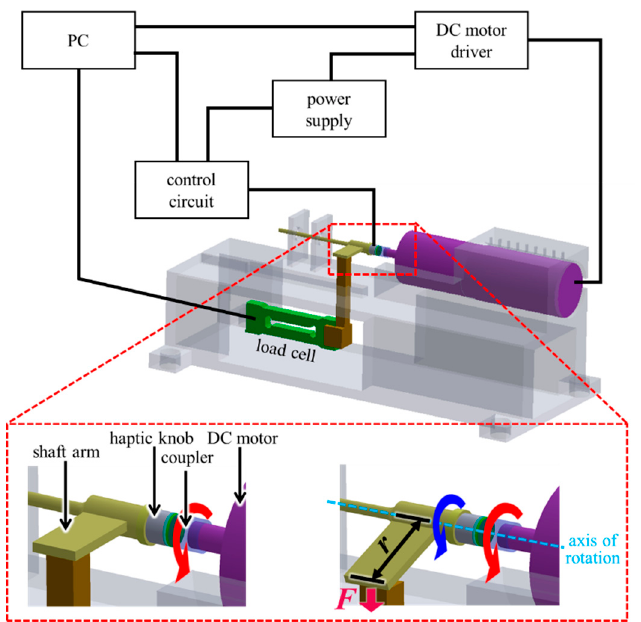
Figure 9. Experimental setup of the proposed actuator.